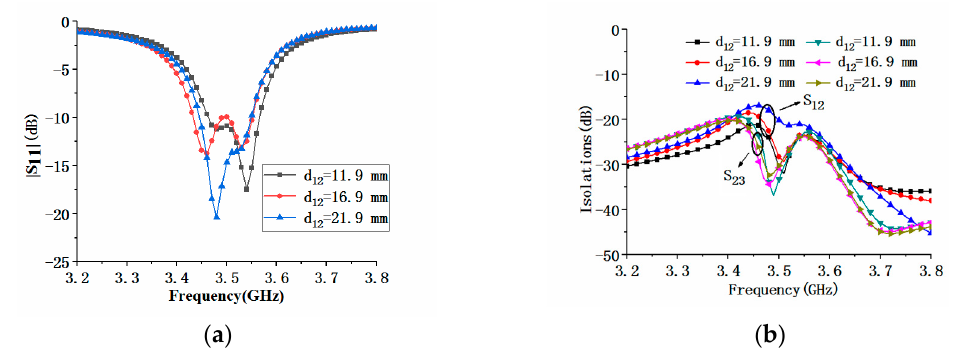
Figure 16. Comparison of |S 11 | and isolation of the proposed antenna with different antenna element spacing d 12 : ( a ) |S 11 | comparison; ( b ) |S 21 |and |S 23 | comparison.